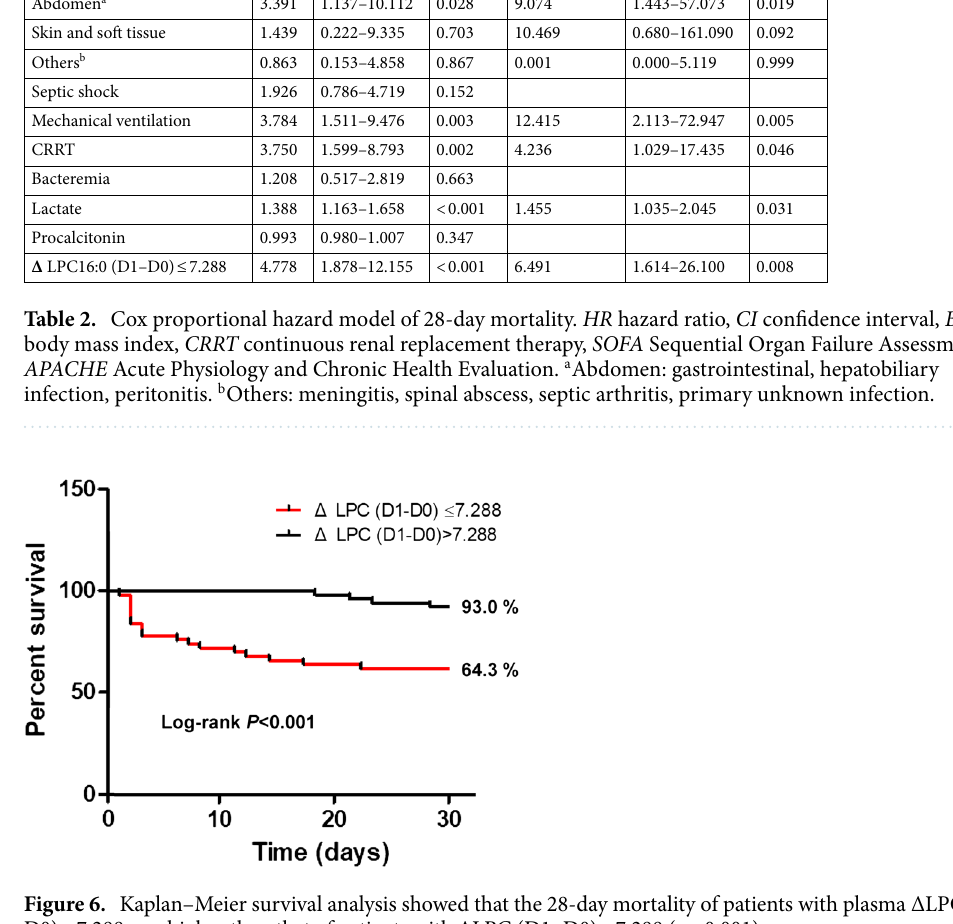
Figure 6. Kaplan–Meier survival analysis showed that the 28-day mortality of patients with plasma ΔLPC (D1– D0) > 7.288 was higher than that of patients with ΔLPC (D1–D0) < 7.288 ( p <